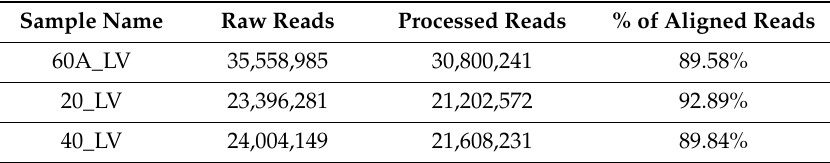
Table 1. Statistics of Labeo rohita liver tissue transcriptome